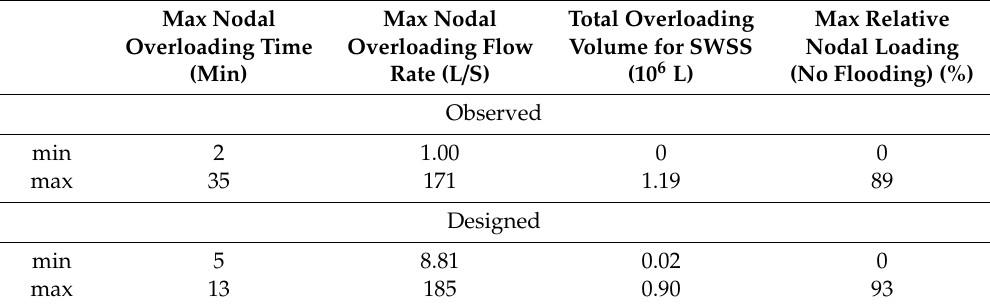
Table 6. Overview of the simulation